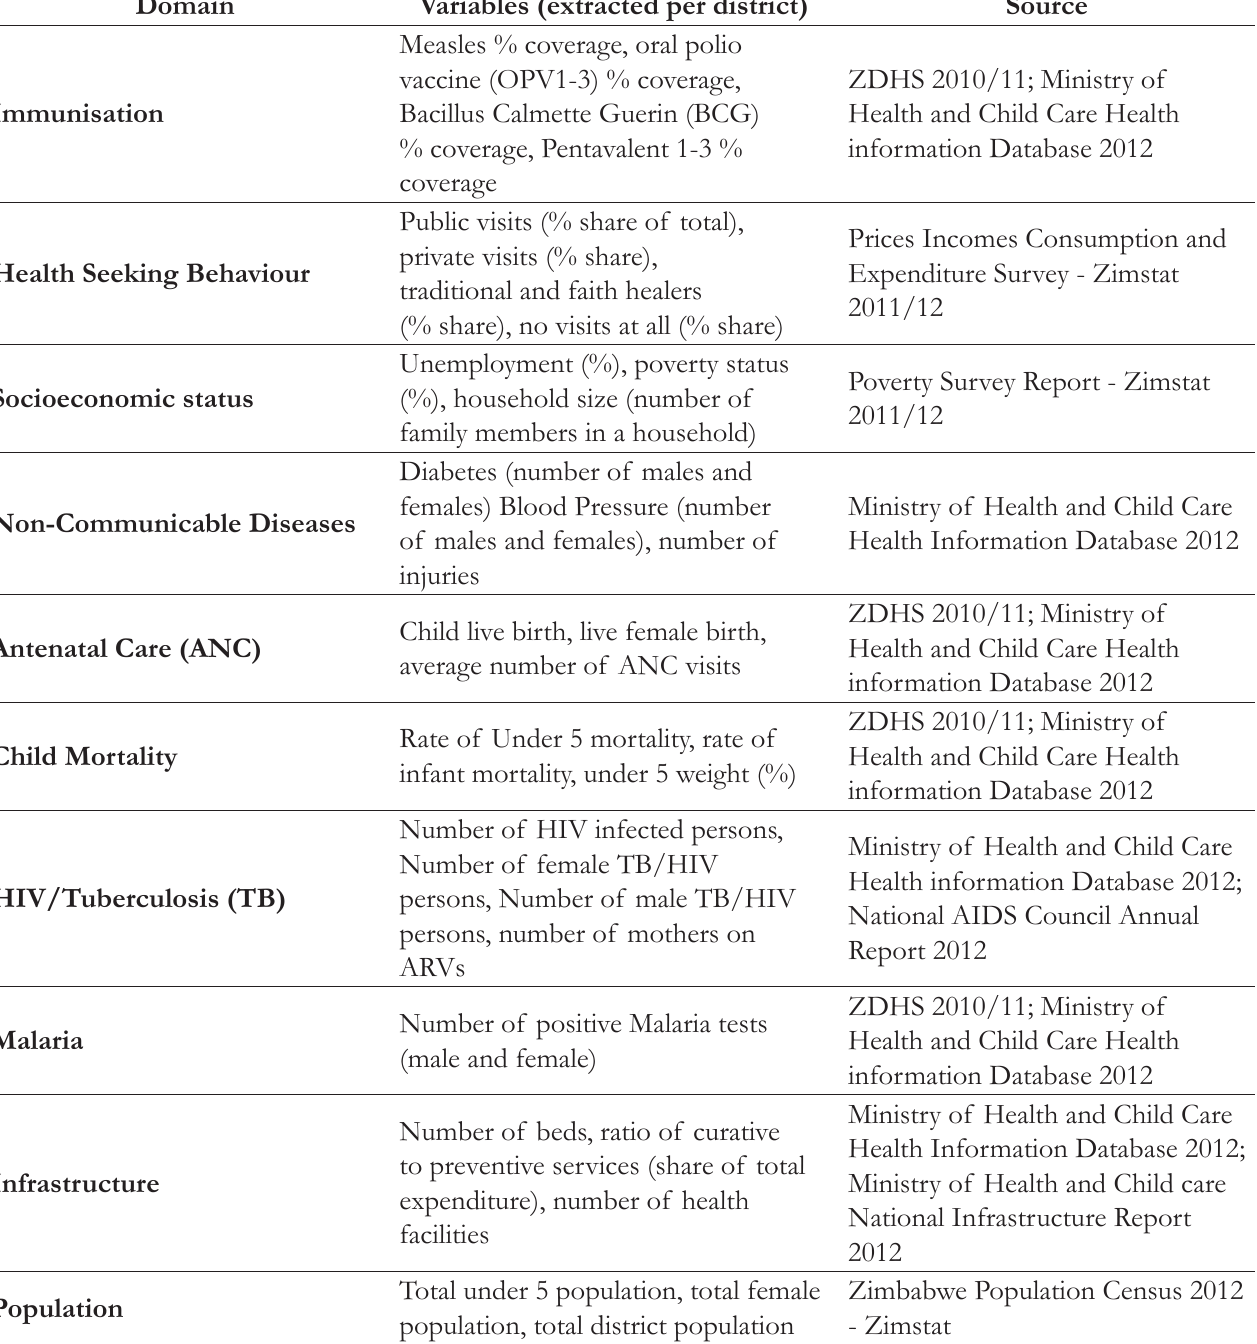
ZDHS: Zimbabwe Demographic and Health Survey; ARV: